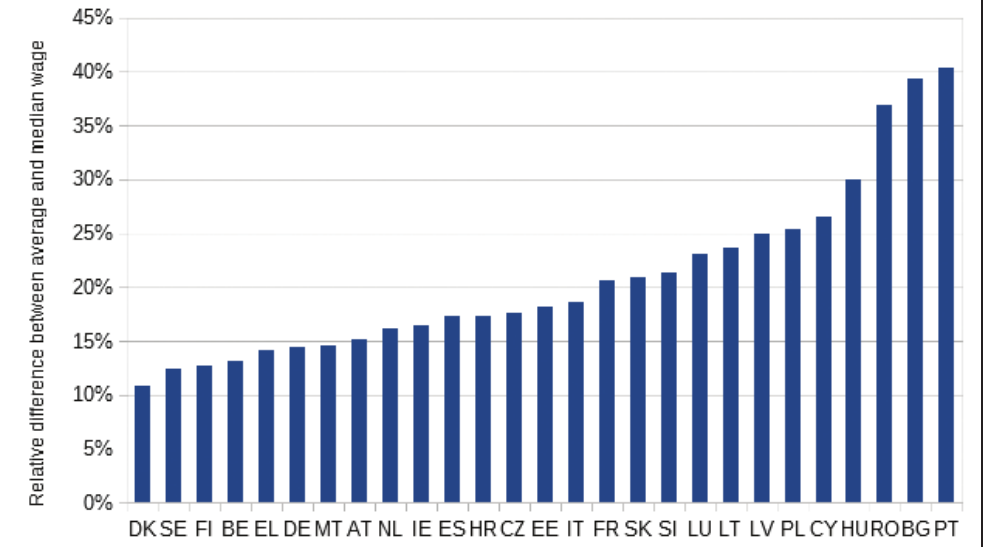
Source : Eurostat. BE, Belgium; BG, Bulgaria; CZ, Czech Republic; DE, Germany; EE, Estonia; EL, Greece; ES, Spain; FR, France; HR, Croatia; HU, Hungary; IE, Republic of Ireland; LT, Lithu- ania; LU, Luxembourg; LV, Latvia; MS, Member States; MT, Malta; MW, minimum wage; NL, The Netherlands; PL, Poland; PT, Portugal; RO, Romania; SI, Slovenia; SK, Slovakia.